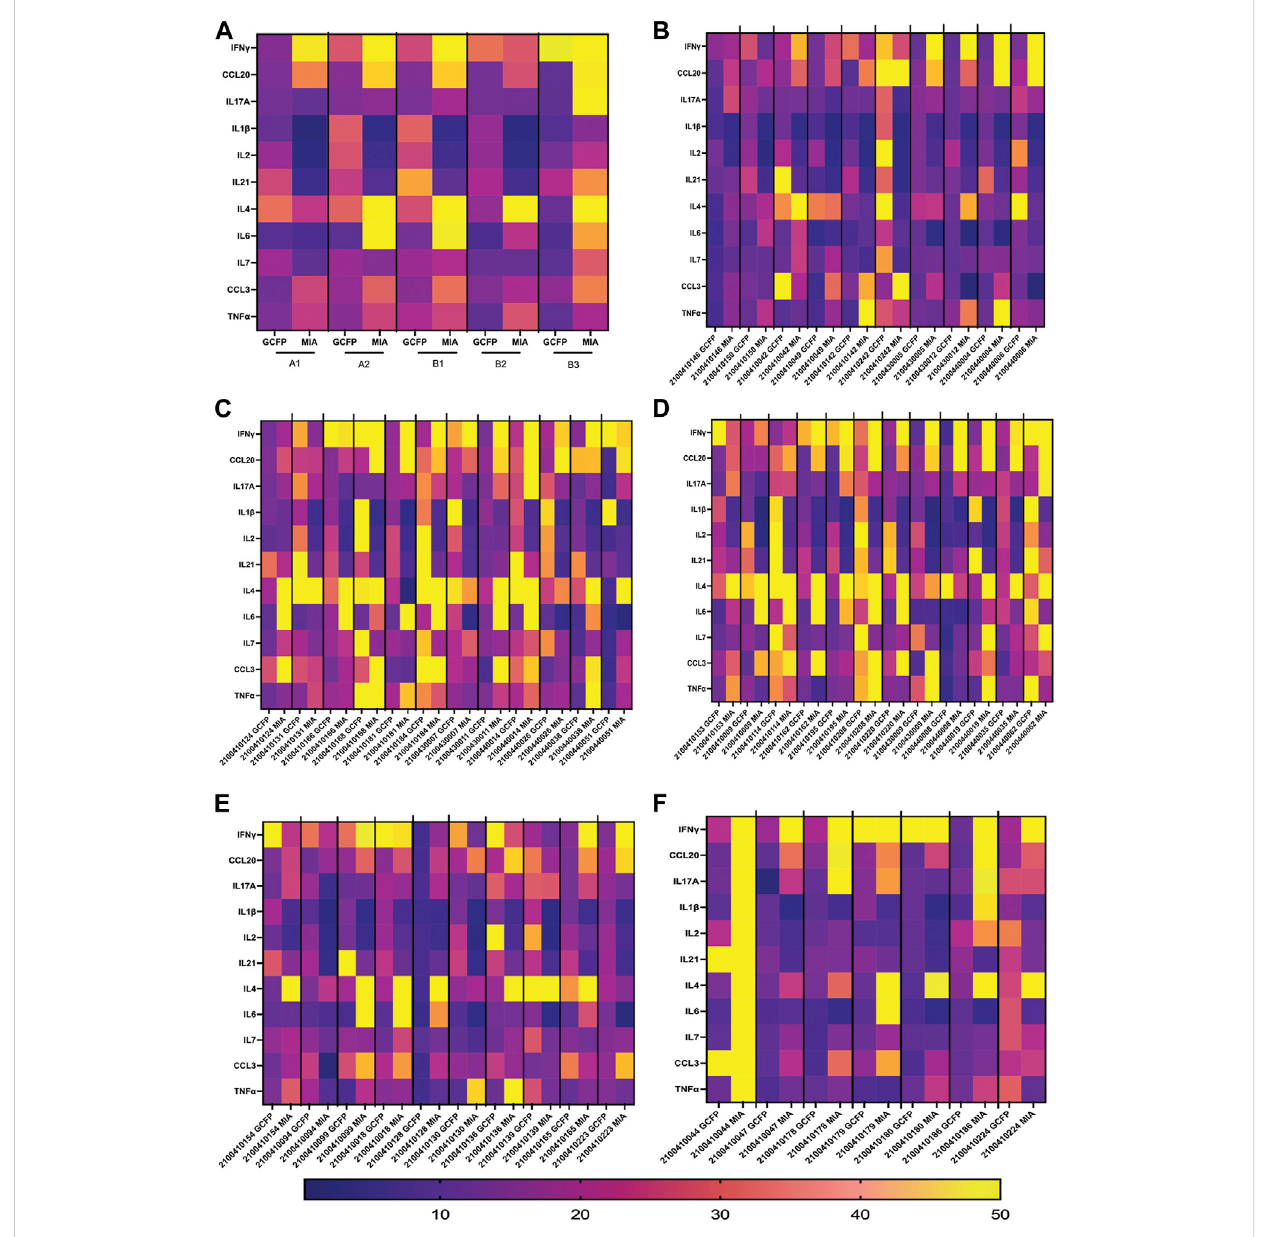
FIGURE 9 Serum from Cohorts and individual patient comparison of GCFP microarray assay to MIA. To compare a traditional MIA with the GCFP microarray, 11 analytes were included in both assays. (A) A heat map was generated by log transforming GCFP detection ratios and using the mean of each analyte detectionratioforeachcohort.Ofthe11analytes,5werebelowthedetectionlimitoftheGCFP fi rstgenerationbiosensorchip. (B) Aheatmapgenerated by log transforming GCFP detection ratios from individual serum samples from cohort A1. (C) A heat map generated by log transforming GCFP detection ratios from individual serum samples from cohort A2. (D) A heat map generated by log transforming GCFP detection ratios from individual serum samples from cohort B1. (E) A heat map generated by log transforming GCFP detection ratios from individualserum samples from cohort B2. (F) A heat map generated by log transforming GCFP detection ratios from individual serum samples from cohort B3. 16 of the 44 shared serum samples had similar biomarker signatures, while IL-4, IL-6 and CCL20 were not consistently detected on the GCFP